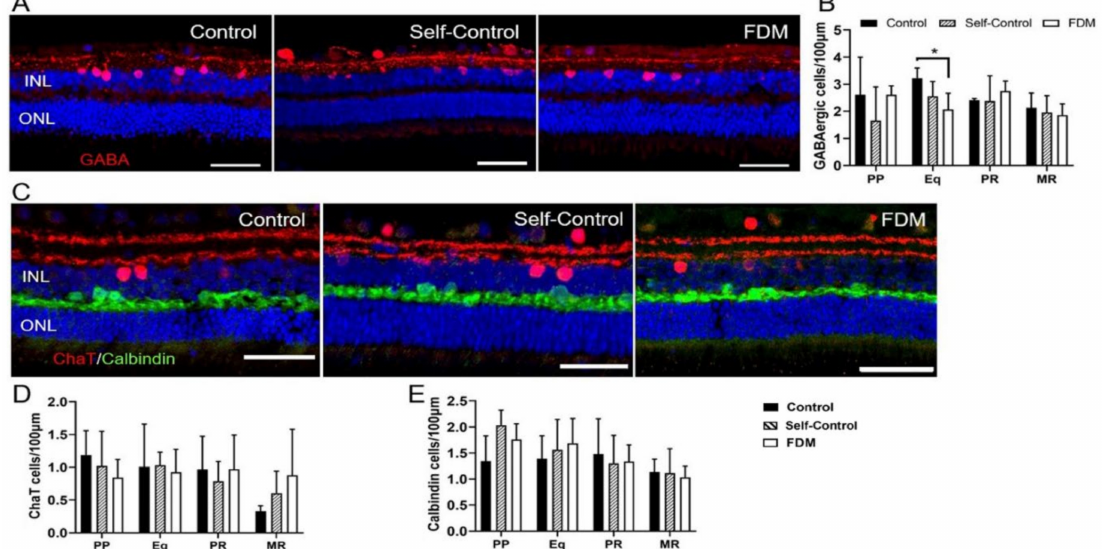
Figure 5. Horizontal cells and amacrine cells in different groups of retinas. ( A ) Representative confocal images of GABA labelled retinas from PP of naïve control, self-control and FDM eyes. Nuclei were stained with DAPI (blue). ( B ) Quantitative data showing the number of GABAergic amacrine cells (INL) in different retinal locations of the three groups guinea pigs. ( C ) Representative confocal images of CHAT (red) and Calbindin (green) labelled retinas from PP of naïve control, self- control and FDM eyes. Nuclei were stained with DAPI (blue). ( D , E ) Quantitative data showing the number of CHATergic amacrine cells ( D ) and calbindin + horizontal cells in different retinal locations of the three groups of guinea pigs. INL, inner nuclear layer; ONL, outer nuclear layer. Scale Bar: 50 µ m. Mean ± SD, n = 3~9/group. * p < 0.05. One-way ANOVA followed by Fisher’s LSD